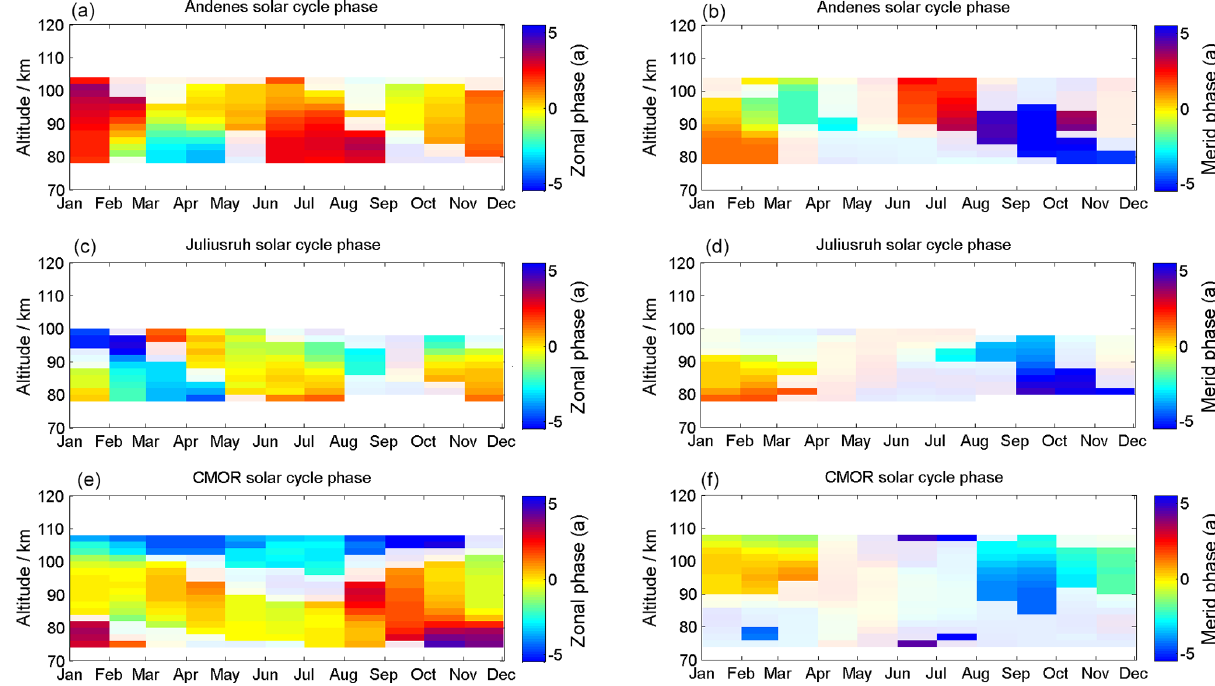
Figure A1. Phase information of the solar cycle fit for the wind component. The shaded areas are not